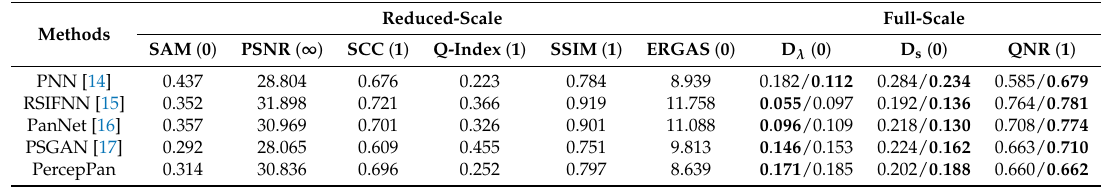
Table 7. Generalization performance of the different methods on the IKONOS dataset. The best value of each index is shown in parentheses.